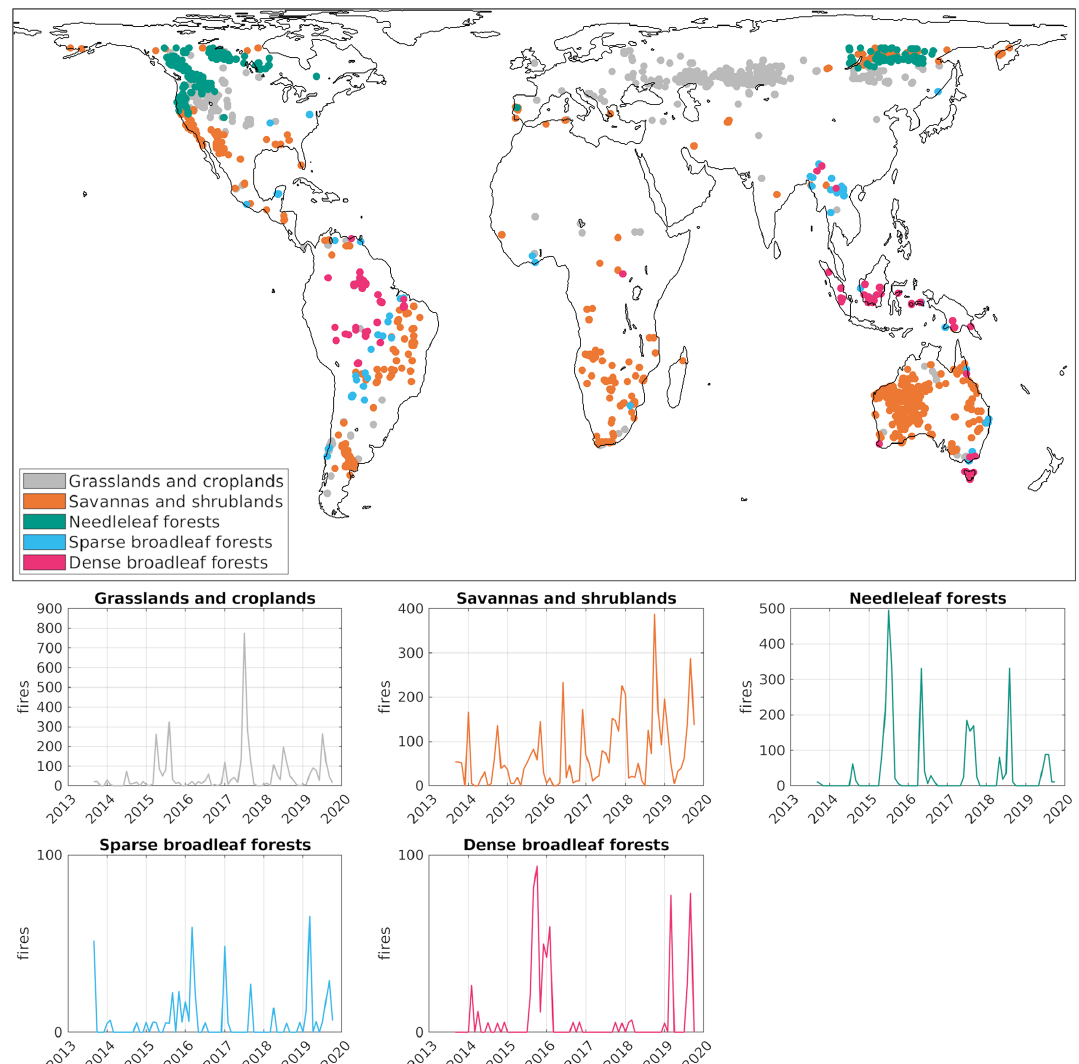
Figure 3. Location of the selected fires and histograms of the fire dates, for grasslands and croplands (IGBP labels 10, 12, and 14), savannas and shrublands (IGBP labels 6, 7, 8, and 9), needleleaf forests (IGBP labels 1 and 3), sparse broadleaf forests (IGBP labels 2 and 4; AGB ≤ 150Mgha − 1 ) , and dense broadleaf forests (IGBP labels 2 and 4; AGB > 150Mgha − 1 ) . Areas affected by water, snow, or strong topography were excluded (see Sect.